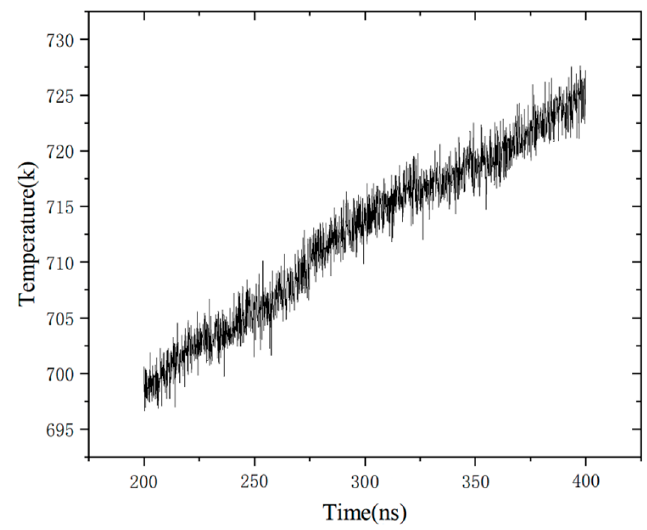
Figure 6. Regular pattern of temperature changed after relaxation.